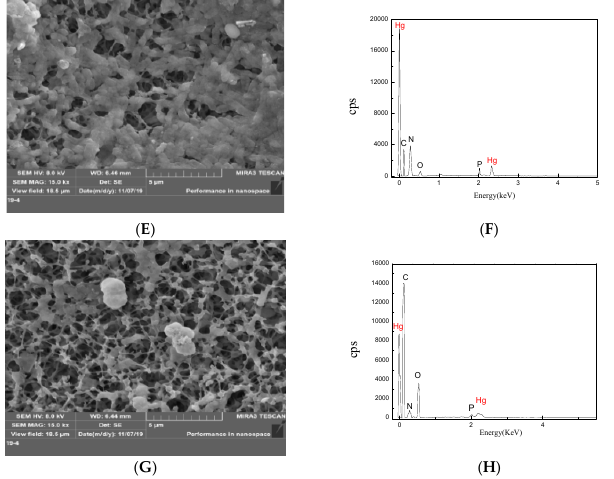
Figure 3. Analysis of Hg(II) adsorption by extracellular polymeric substances (EPSs) produced by the RTS-4 bacteria. ( A ) Residual Hg concentration in the solution after pure water adsorption in the dialysis bag at different times (control group); ( B ) residual Hg concentration in the solution after EPS adsorption in the dialysis bag at different times; ( C ) removal rate of Hg(II) by EPSs at different times; ( D ) infrared spectrometric analysis of extracellular polymeric substances (EPS) cultured in liquid medium with (red line) and without (black line) Hg(II) (the numbers indicate the peak positions of the functional groups); ( E ) scanning electron microscopy (SEM) photograph of the surface of the RTS-4 bacterial cells that were cultured in the liquid medium containing 50 mg/L Hg(II); ( F ) precipitation element analysis by energy dispersive spectroscopy (EDS) on the surface of the RTS-4 bacterial cells that were cultured in the liquid medium containing 50 mg/L Hg(II); and ( G ) SEM photograph of the surface of the EPSs that were produced by RTS-4 bacteria in the liquid medium containing 50 mg/L Hg(II). ( H ) Precipitation element analysis by EDS on the surface of the EPSs that were produced by the RTS-4 bacteria in the liquid medium containing 50 mg/L Hg(II). Bars (means values ± SD) with different letters are significantly different from the three independent experiments at the 0.05 level, according to LSD multiple comparisons.